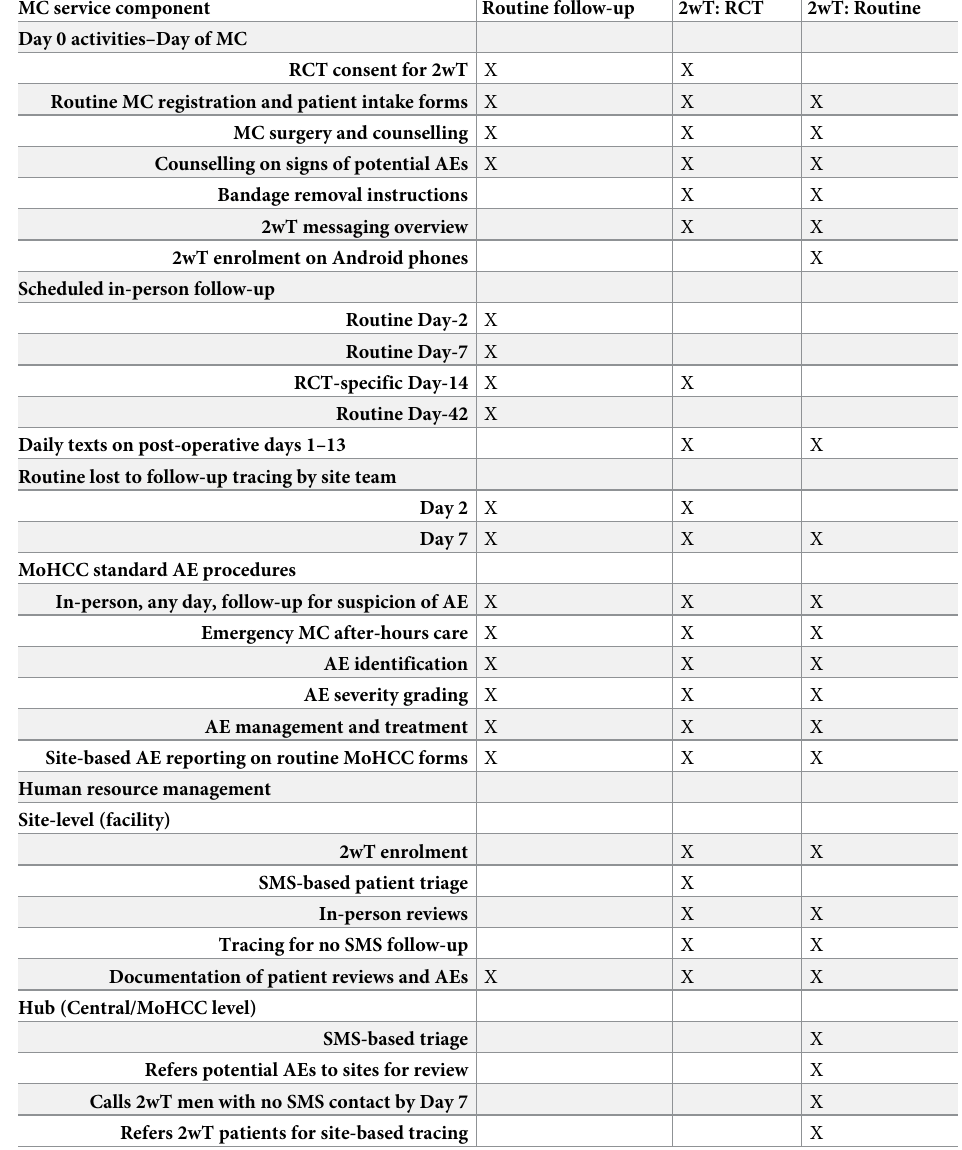
Table 1. Comparison of MC procedures: routine follow-up; 2wT in RCT; and 2wT in routine settings. MC service